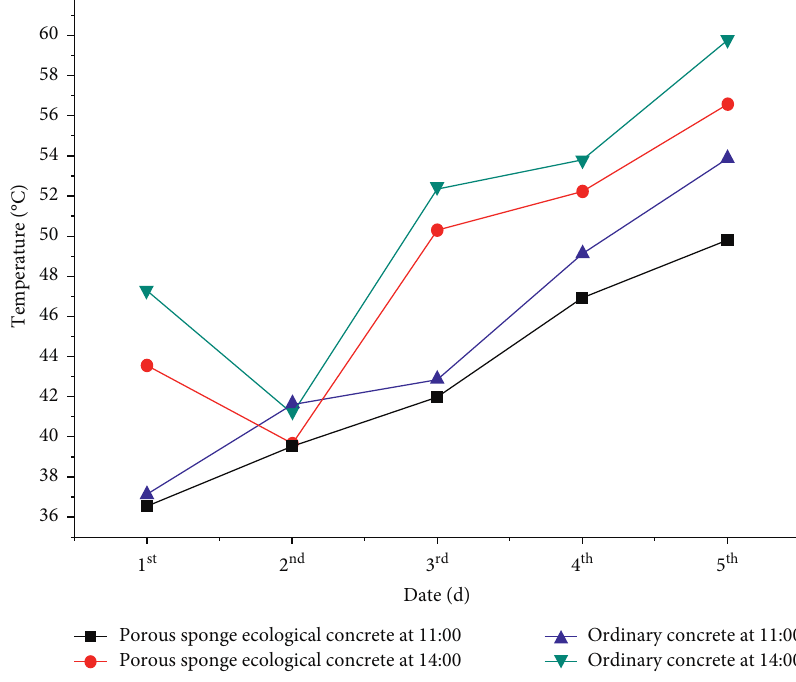
Figure 6: Temperature variation curve at 11: 00 and 14 :00 within 5 days.